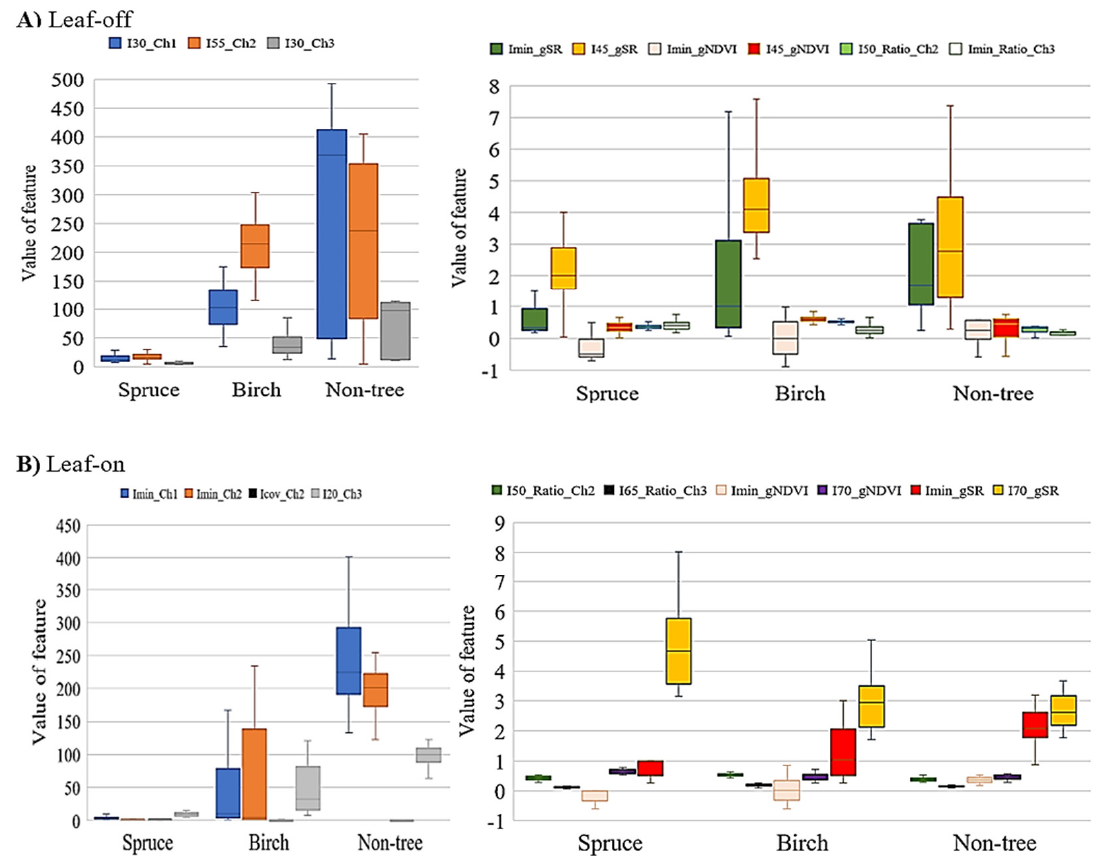
Figure 4. Box-whisker plots of the selected most important and uncorrelated features (green-colored features in Table 5). The boxes show the mean and first and third quantiles in the box, as well as the minimum and maximum values in line, using validation data with a canopy threshold (C th ) of 0.4 m in leaf-o ff ( A ) and leaf-on ( B ) conditions. Features of single- and multi- channel intensity (SCI and MCI, respectively) data are plotted in left and right, respectively. Explanations for features are provided